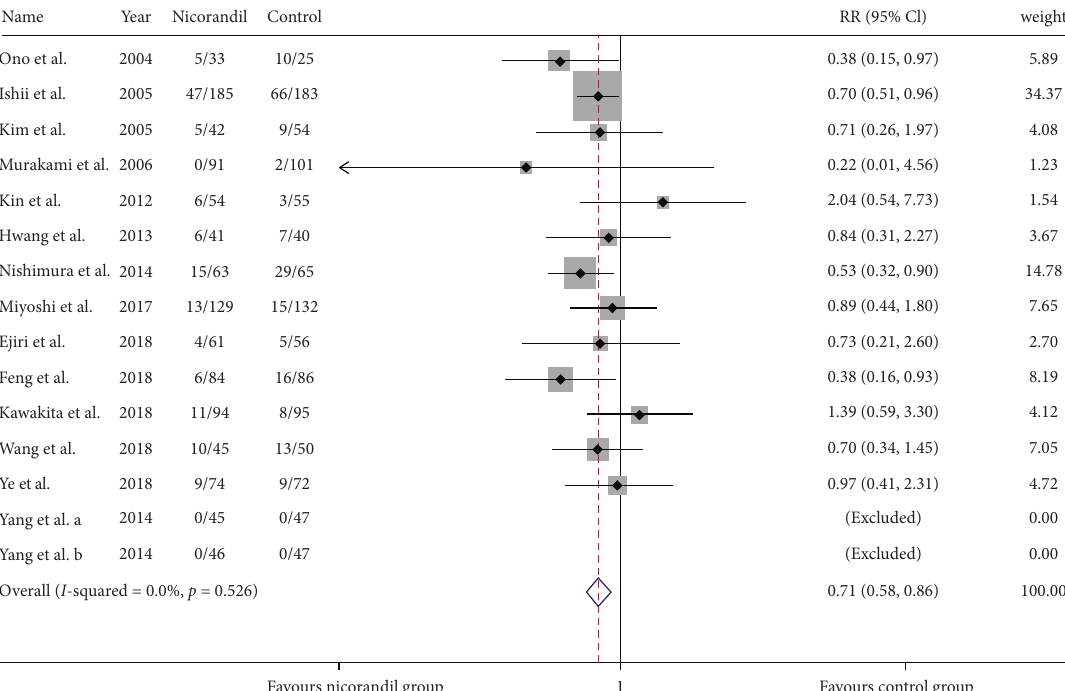
Figure 3: Comparison of MACE between the experimental group and the control group. RR � risk ratio; MACE � major adverse car- diovascular event.